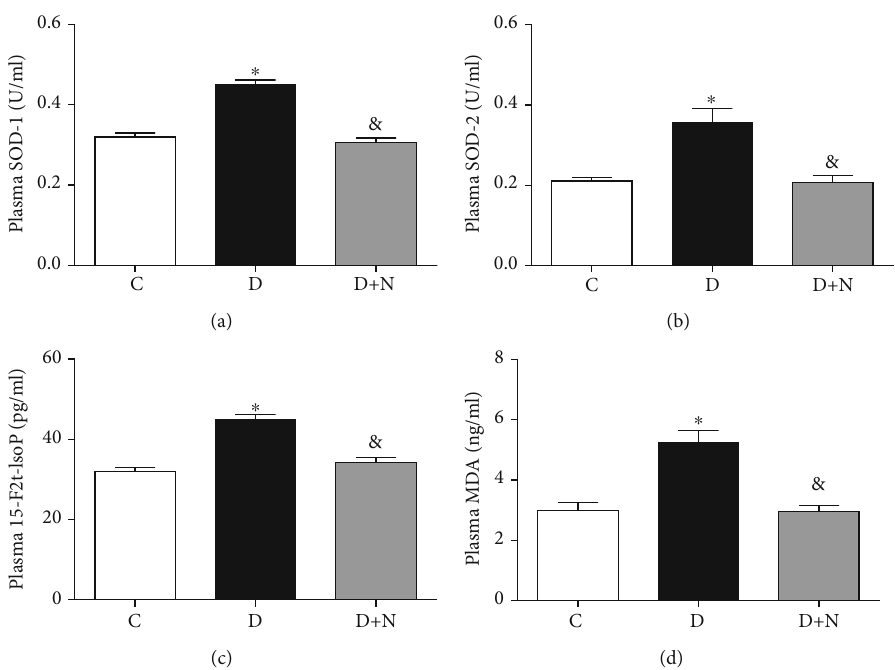
Figure 7: E ff ect of three weeks of NAC treatment on change in plasma SOD-1, SOD-2, MDA, and 15-F2t-Isoprostane level of diabetic rats measured by ELISA analysis. All results are presented as means ± SD , n = 6 /group; ∗ P < 0 : 05 (D vs. C), & P < 0 : 05 (D+N vs.